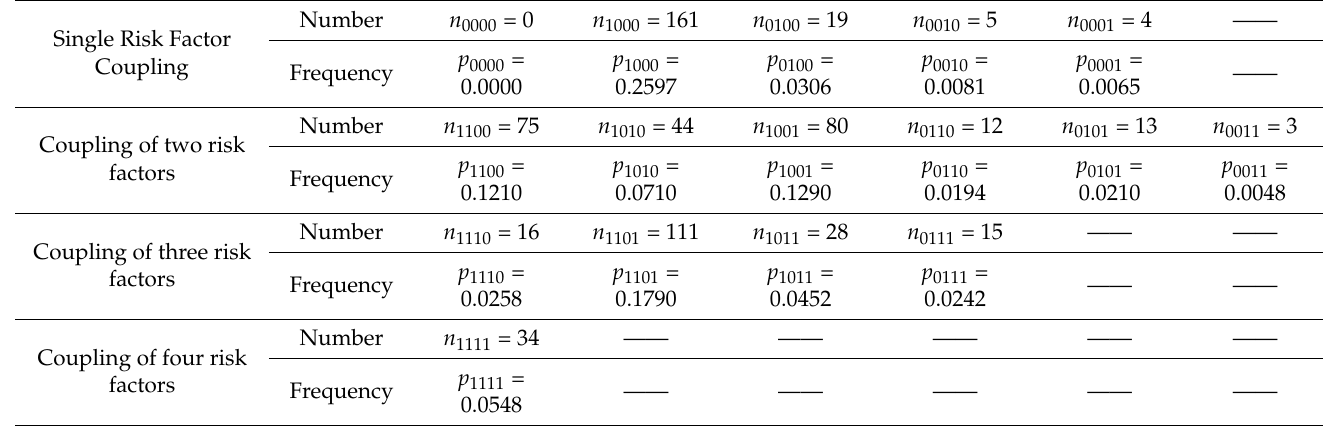
Table 3. Number and frequency of risk coupling of marine accidents.